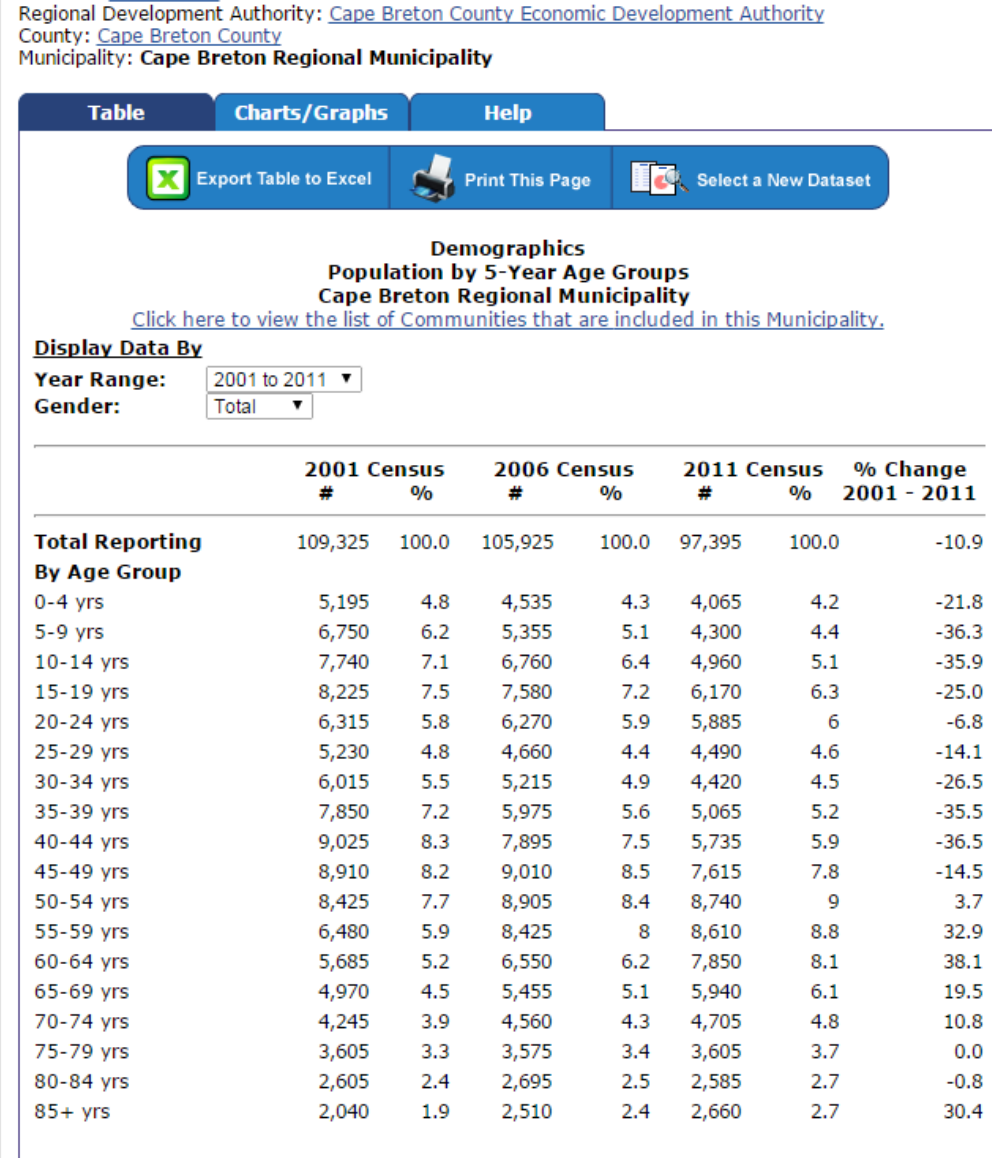
Figure 1: Example of Community Counts’ datasets illustrating population by five-year age group